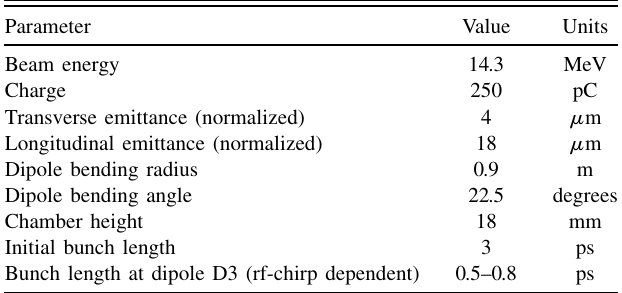
TABLE I. Nominal A0 beam parameters.